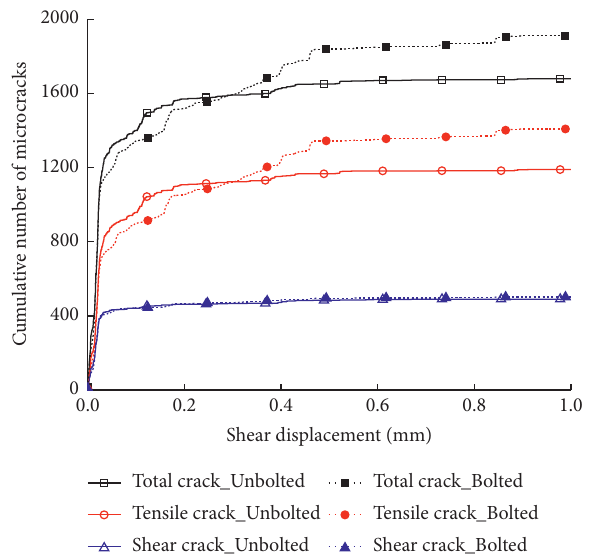
Figure 15: Relationship between shear displacement and micro-cracks.